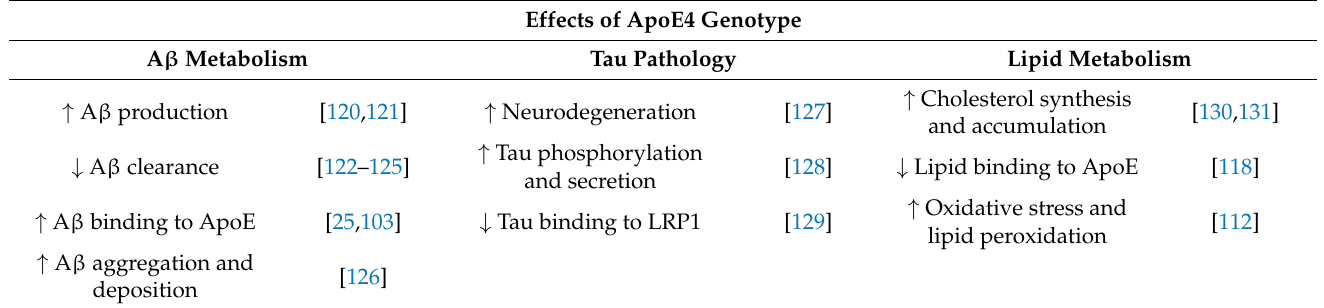
Table 2. Deleterious effects of ApoE4 isoform in AD